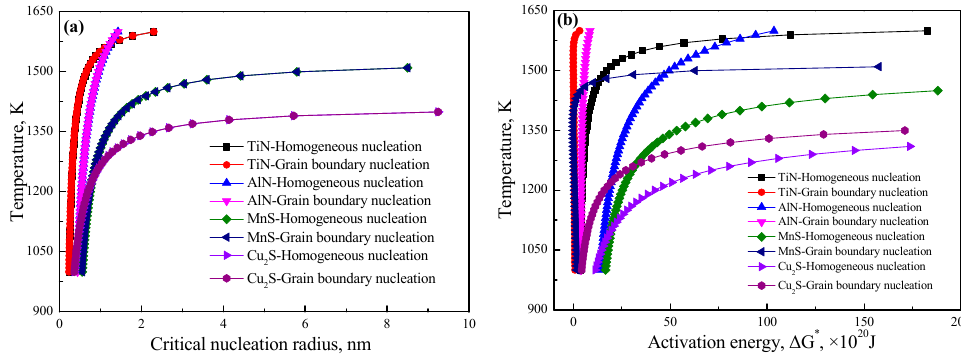
Figure 8. Critical nucleation radius ( a ) and activation energy ( b ) for new phases nucleation vs. temperature.